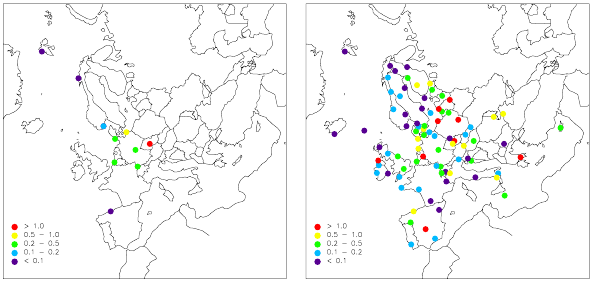
Fig. 22. Spatial patterns for pyrene in air (left) at EMEP stations in 2009, and (right) measured using passive air samplers across Euro- pean background stations in 2006 (from Halse et al., 2011). Unit: ng m − 3